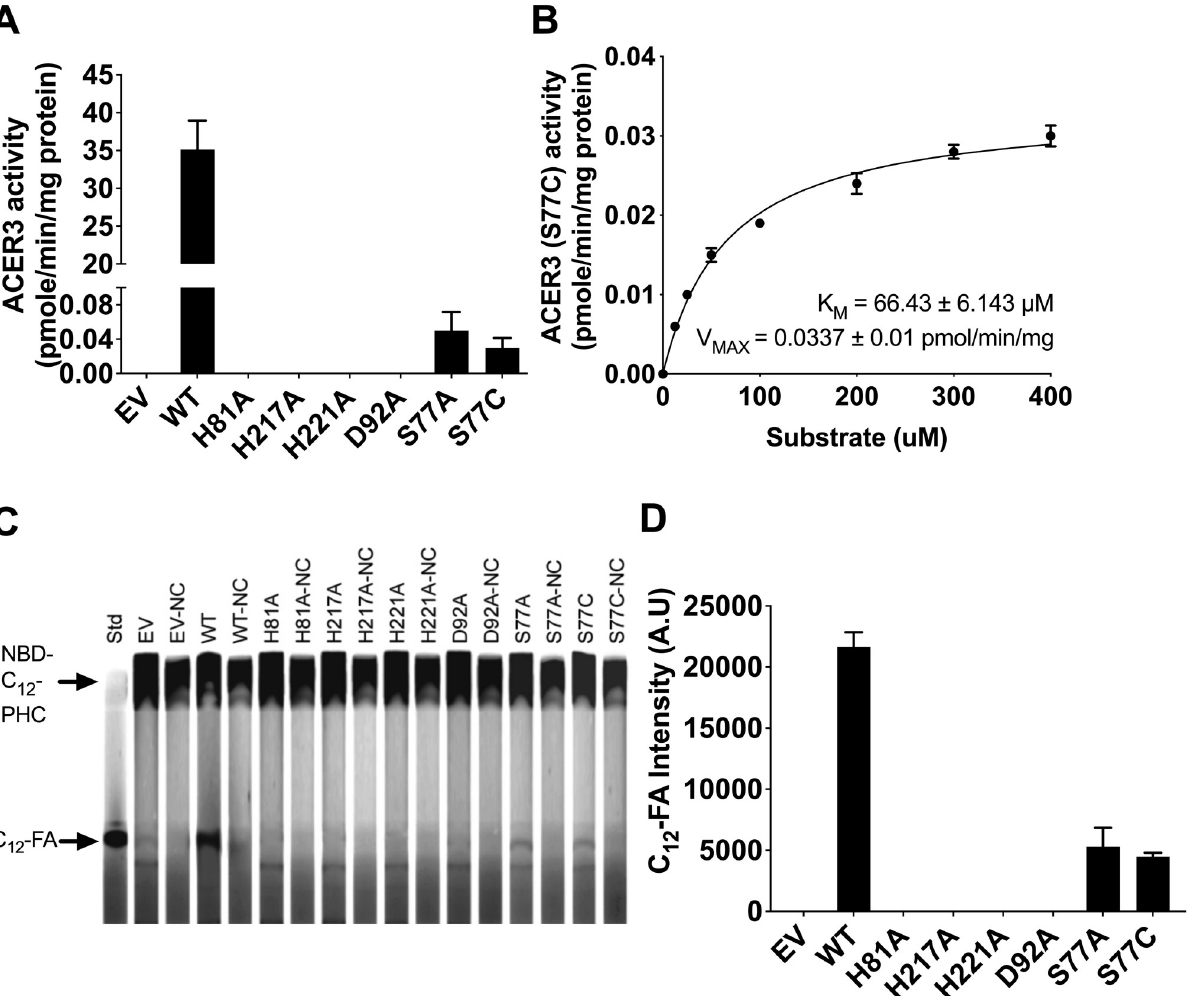
Fig 3. Role of Ser77 in ACER3 catalytic site. (A) Microsomes from WT and each mutant ACER3 were subjected to alkaline ceramidase activity using NBD-C 12 -PHC at pH 7.5. The release of the fluorescent product NBD-C 12 -FA from the substrate NBD-C 12 -PHC was detected by HPLC. (B) Microsomes from S77C were measured for in vitro ceramidase activity on various concentrations of NBD-C 12 -PHC at pH 7.5. K M and V MAX values are indicated. Reactions were conducted with 1 μ g of microsome at 37˚C for 30 min. Data represent the mean ± S.D. of three independent experiments performed in duplicate. (C) Microsomes from wild-type and each mutant ACER3 were subjected to alkaline ceramidase activity using NBD-C 12 -PHC. The release of the fluorescent product NBD-C 12 -FA from the substrate NBD-C12-PHC was detected by TLC. NC, Negative Control (heated microsomes) (D) Intensity of C 12 -FA in (C) was measured by ImageJ (NIH, 1.53a).